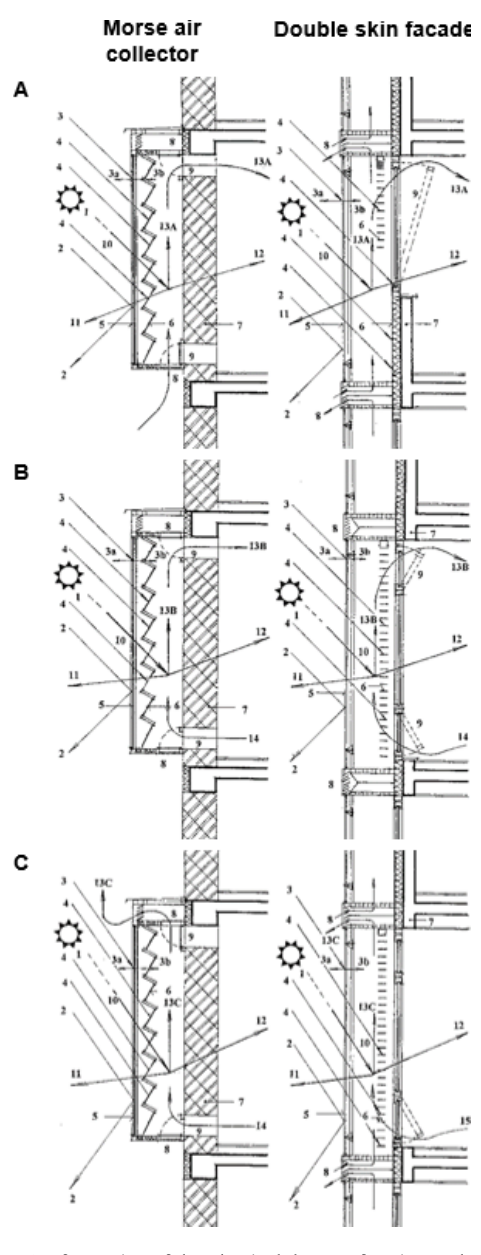
Figure 1: Confrontation of the physical theory of cavity on the prin- ciple of a single air collector and a double skin facade A - hot air ventilation mode during the winter period B - circulating air heating mode during the transition period C - passive cooling mode during the summer period 1 - global shortwave solar radiation, 2 - reflected shortwave radiation, 3 - glass absorbed radiation, 3a - longwave radiation radiated to the exterior, 3b - longwave radiation radiated to the interior, 4 - transmitted shortwave radiation transformed in the cavity into longwave thermal radiation 5 - collector, 6 - absorber, 7 - accumulator, 8 - distributor, 9 - regulator, 10 - intensity of trans- mitted global solar radiation, 11 - heat flow by transmission to the exterior, 12 - heat flow by transmission to the building core, 13A - heat consumed for heating the air in the cavity - used for hot air ven- tilation, 13B - heat consumed for heating the air in the cavity - used for heating by circulating air, 13C - heat consumed for heating the air in the cavity, which is dissipated to the exterior, 14 - circulating air supply from the building core, 15 - ventilated air supply from the north side - passive